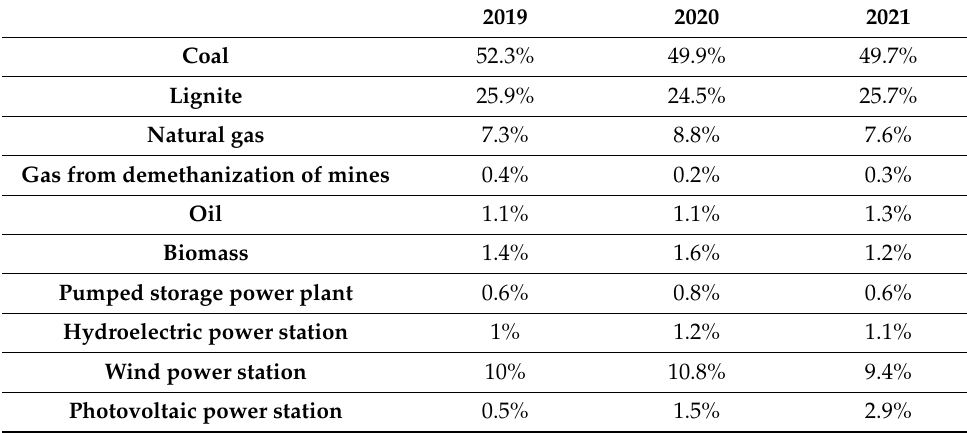
Table 1. The structure of electricity production in Poland in 2019–2021.